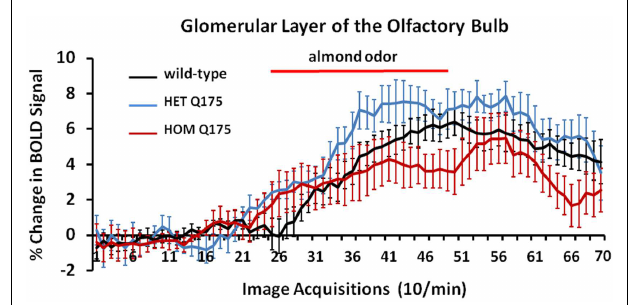
FIGURE 7 | Blood oxygen level dependent signal change over time in response to almond odor . Shown are the changes in the BOLD signal in the glomerulus of the olfactory bulb for each genotype in response to the presentation of almond odor following a 2min baseline of 20 image acquisitions.While the time series are similar in that each genotype shows a comparable baseline and onset of activation there is a significant difference between the time series and an interaction between the time series and genotypes as shown in the two-way repeated measures ANOVA. Each time point is the mean BOLD signal ± SEM.